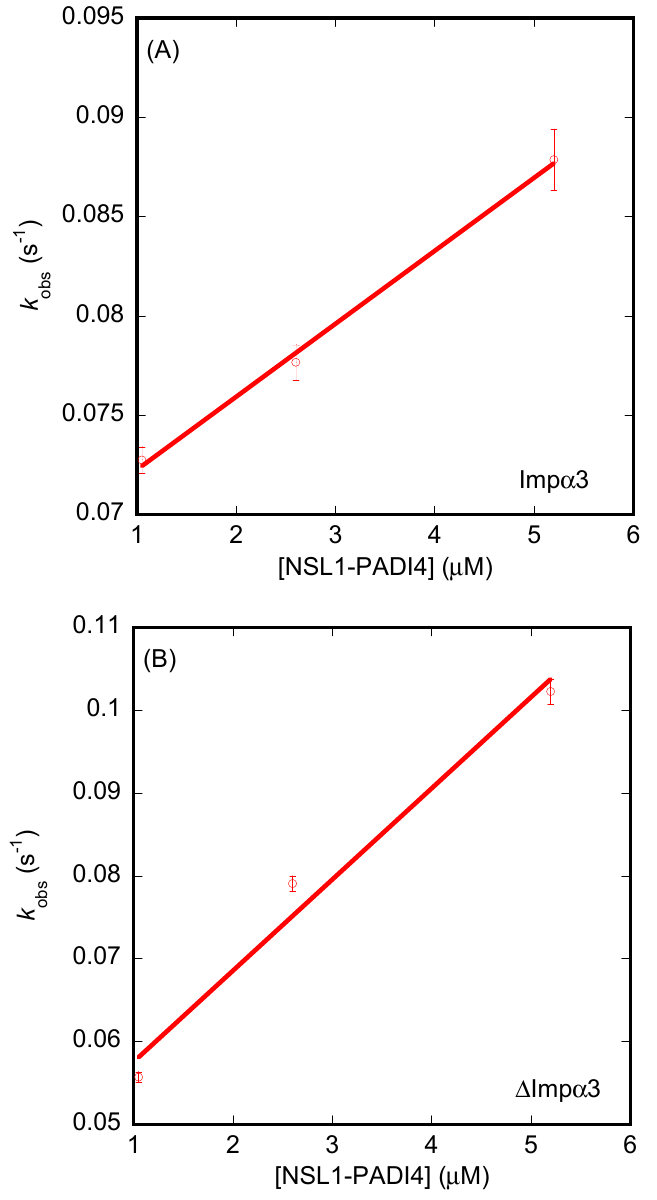
Figure 7. Binding of importin species to NLS1-PADI4 as monitored by BLI. ( A ) Pseudo-first-order plot of the binding of the peptide to Imp α 3 (Equation (6)). ( B ) Pseudo-first-order plot of the binding of the peptide to ∆ Imp α 3 (Equation (6)). The error bars in both panels are fitting errors to the exponentials of the sensorgrams. Experiments were carried out at 25 °C.